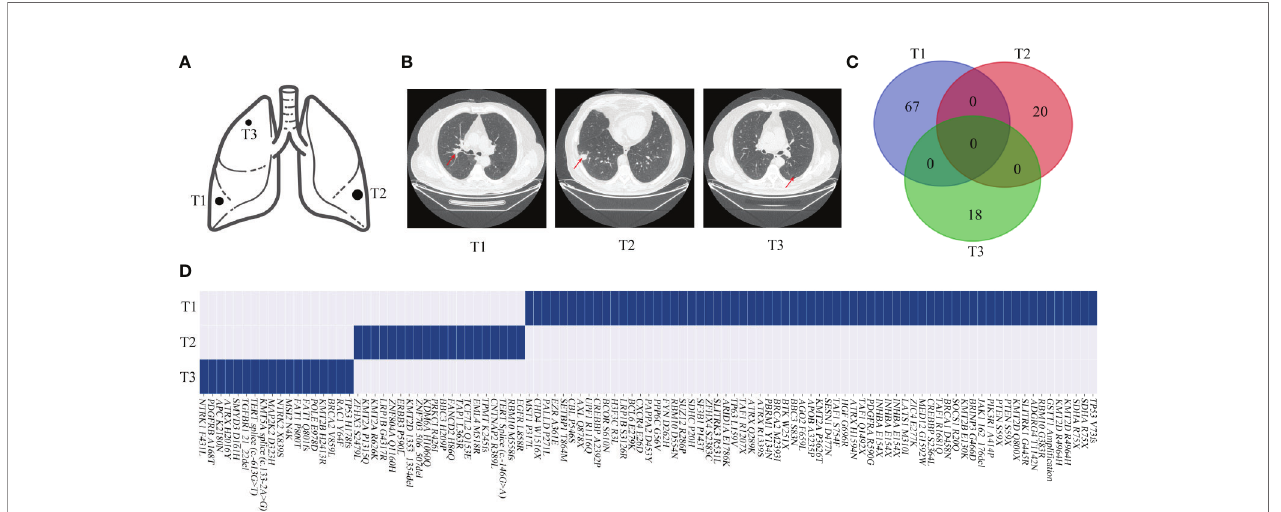
FIGURE 8 | Genomic mutations and computed tomography (CT) images of patient 13. (A, B) Schematic diagrams of lung lesions and corresponding CT images. (C, D) Relationship of the mutations between different lesions exhibited by a Venn diagram and the mutation distributions of patient 13. The arrow indicates the tumor